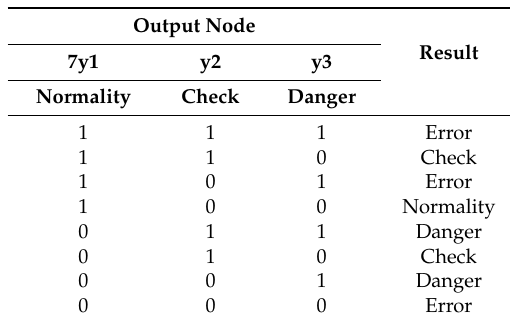
Table 2. The result of the